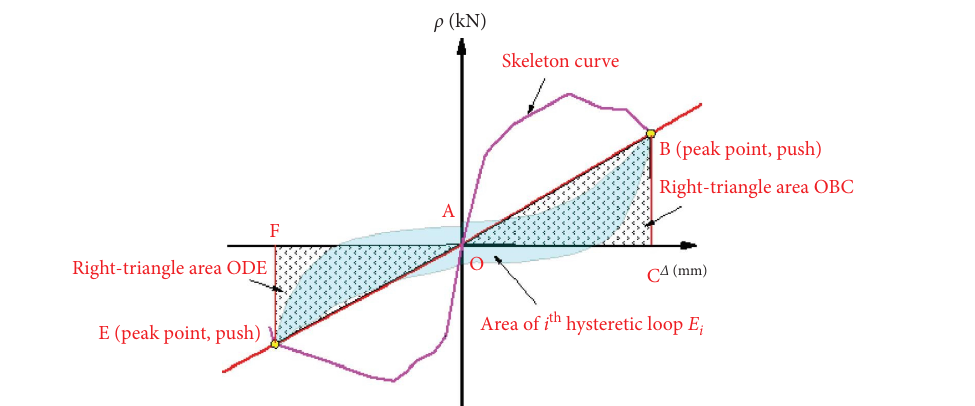
Figure 20: Calculation chart of energy dissipation